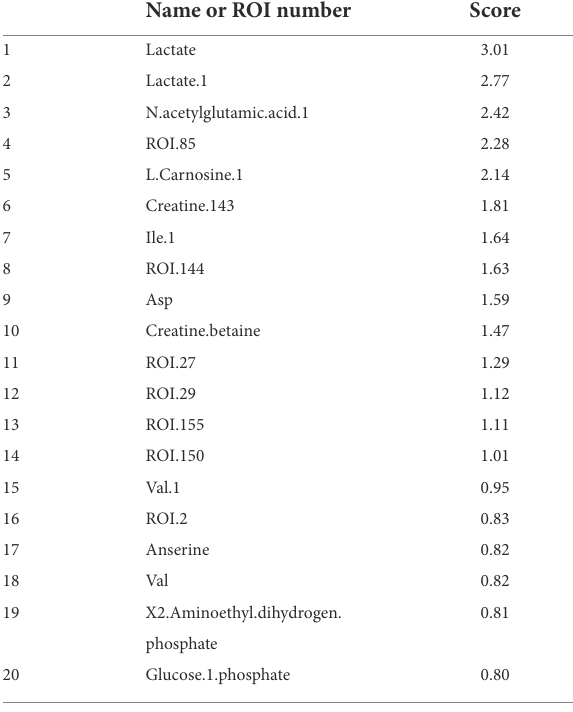
TABLE 2 NMR importance ranking for separating intrasalmoniformes computed using the i-means method. Name or ROI number